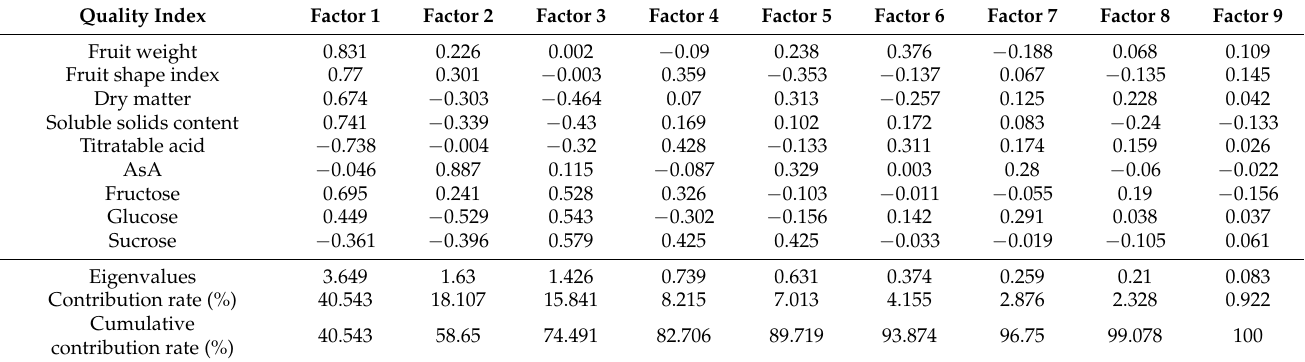
Table 3. Principal component analysis of fruit quality for different wild A. eriantha varieties